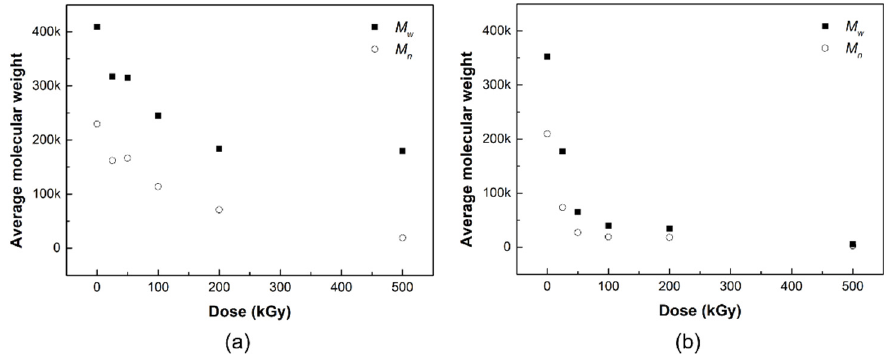
Figure 5. Average molecular weight (black squares: M w , white circles: M n ) of ( a ) PLCL and ( b ) PLDLA depending on the gamma-ray irradiation.